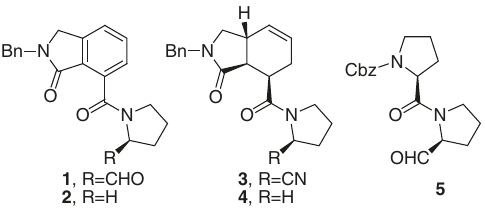
Fig. 1 POP inhibitors employed in this study. Bn and Cbz indicate benzoyl and carboxybenzyl groups,